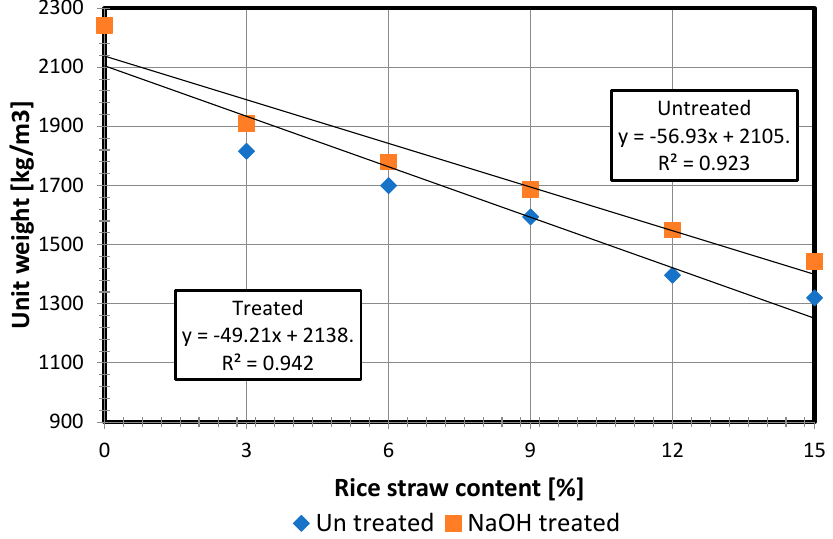
Figure 5. Dry unit weights of the treated and untreated rice straw concrete at different rice straw